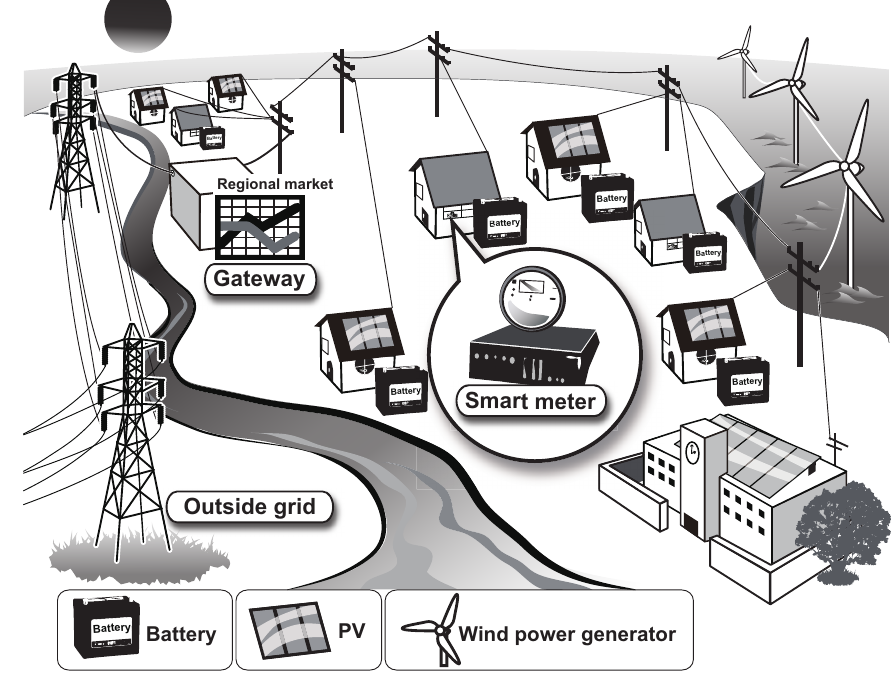
Figure 1. Overview of the inter-intelligent renewable energy network